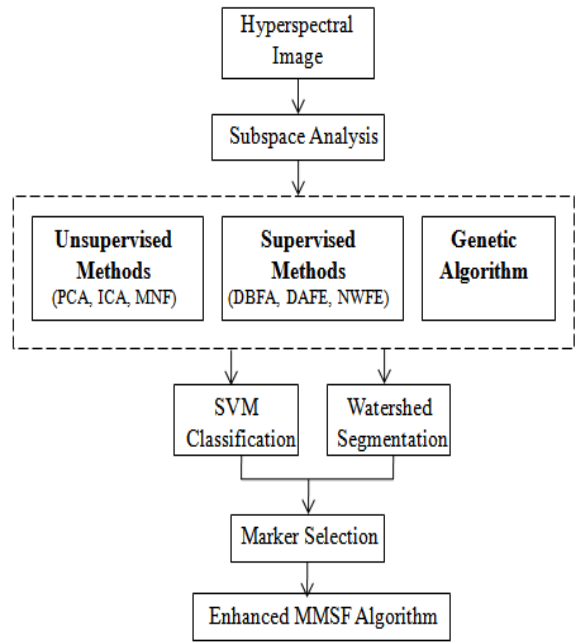
Figure 1. Schema of the proposed approach.